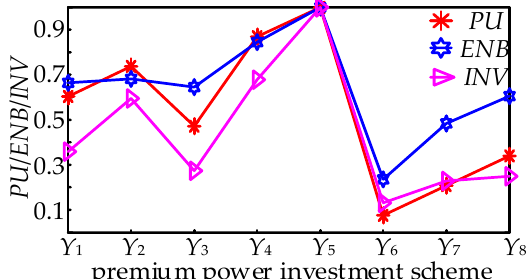
Figure 12. As for customer L 1 , comparison among PU , expected net benefit ( ENB) and investment ( INV) for Y 1 ~ Y 8 .